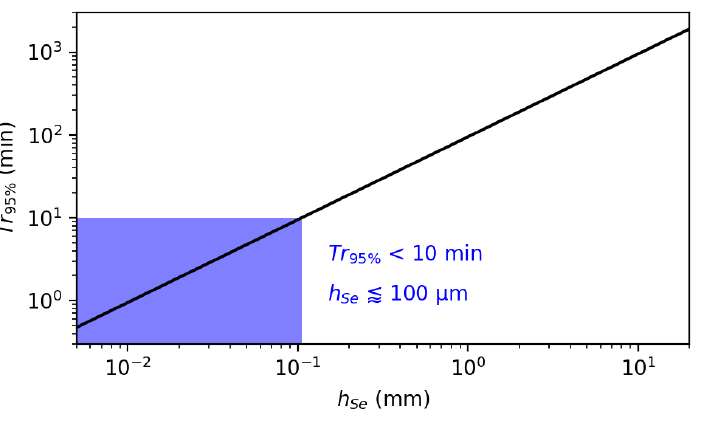
Figure 15. 95% response time ( Tr 95% ≈ 3 · τ ) of a closed-chamber sensor of height h Se . The blue area underlines the portion of the line with a response time below 10 min, which corresponds to a sensor height below approximately 100